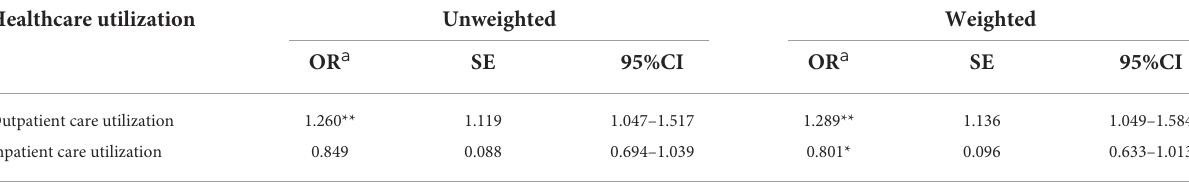
TABLE 5 Combined data for CHARLS 2015 and 2018: Effects of community-based diabetes examination on healthcare utilization (logit model). Healthcare utilization